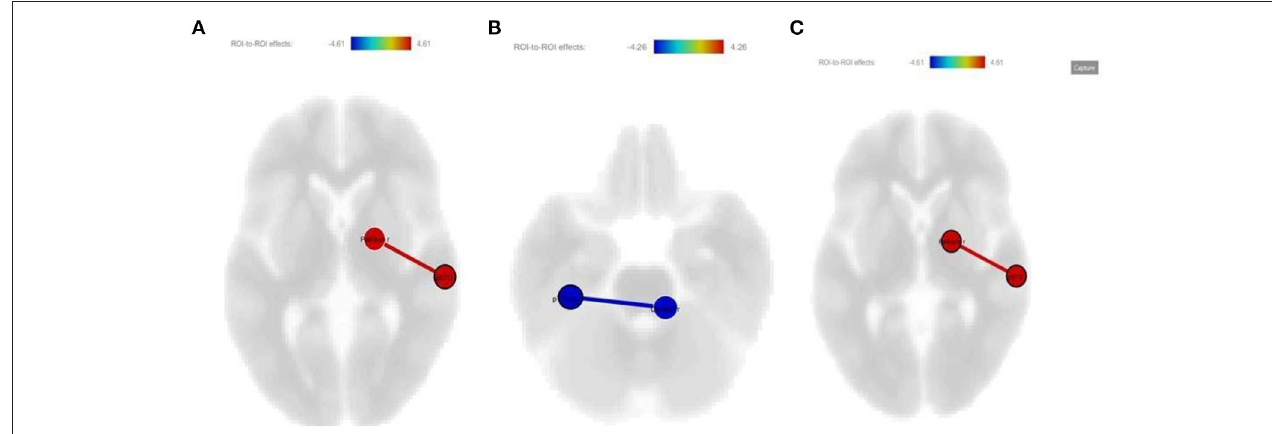
FIGURE 1 | (A) Increased connectivity between right posterior STG and right pallidum after treatment in the medication-only group ( p- unc: 0.0001; p -FDR: 0.0178); (B) Decreased connectivity between the left pTFus C and right cerebellum 3 after treatment treatment in the medication-only group ( p -unc: 0.0002; p -FDR: 0.0385); (C) All ROI’s are shown together as a